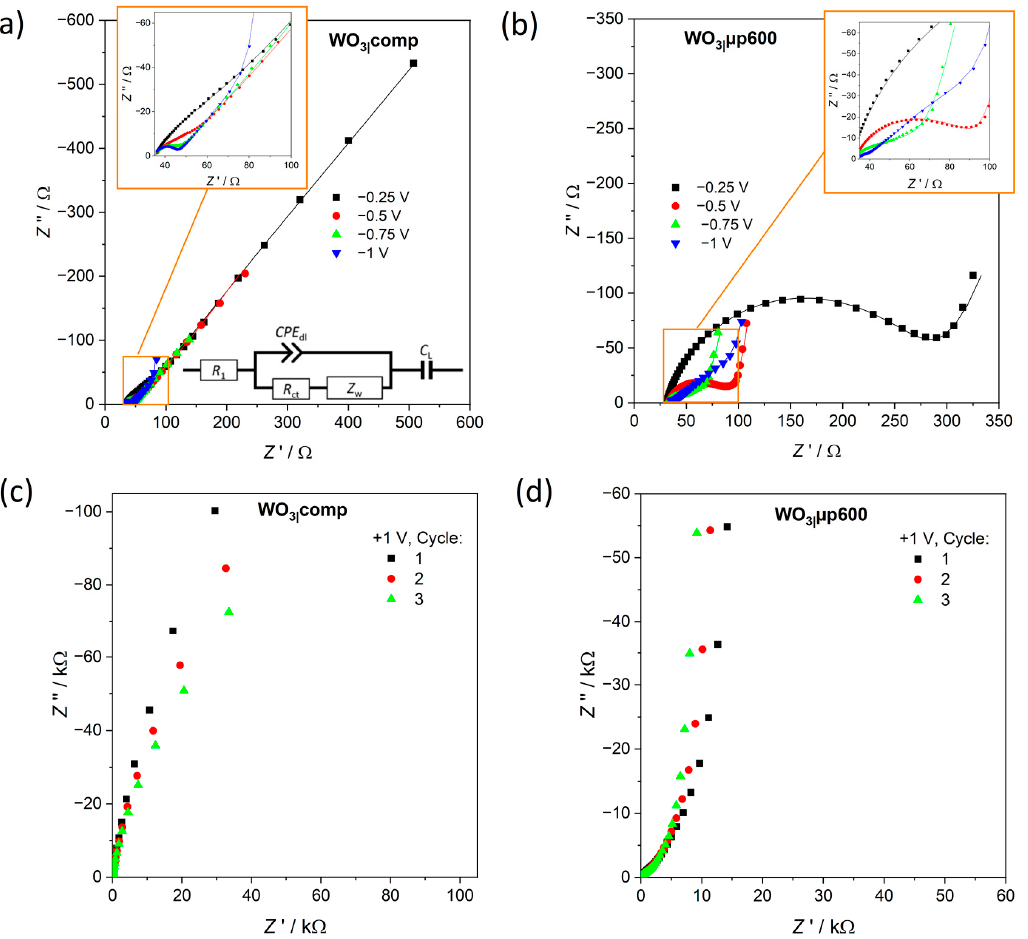
Figure 12. Nyquist plots of a WO 3| comp film ( a , c ) and a WO 3| µp600 film ( b , d ) at different negative applied potentials and at the bleached state (1 V). The insets show the impedance data at high frequencies ( a , b ) and the equivalent circuit ( a ) used for fitting the data with the resistances R 1 and R ct , the Warburg impedance Z w , the constant phase element CPE dl and the capacitance C L